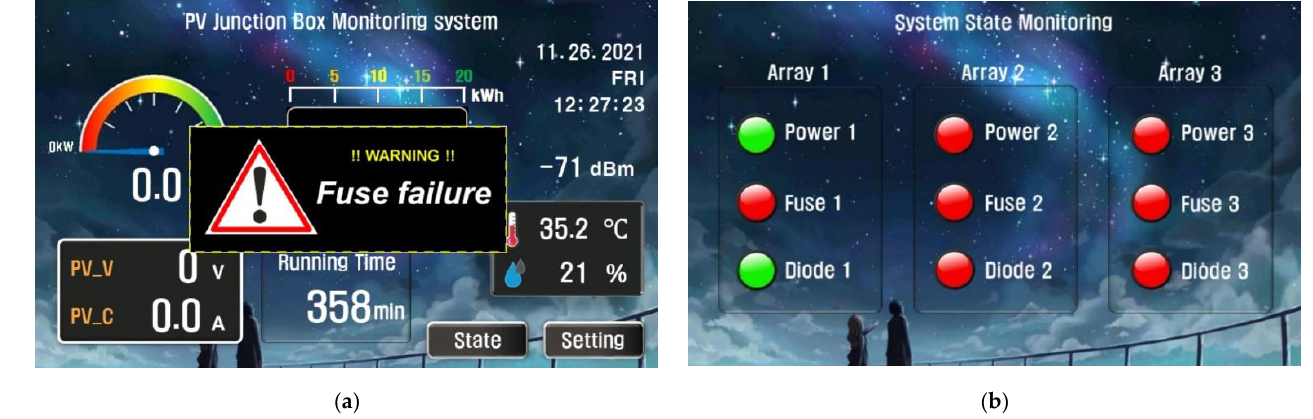
Figure 15. The warning message and PV junction box conditions displayed on the LCD screen of monitoring device: ( a ) Pop-up warning message; ( b ) PV junction box component status for each PV array.